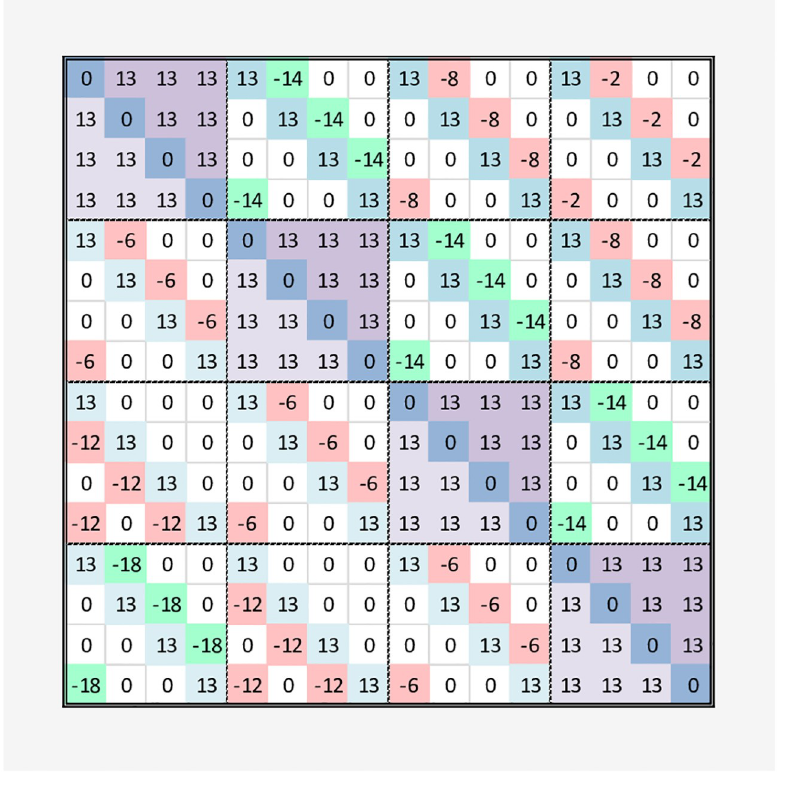
Fig 7. Q-matrix for de novo